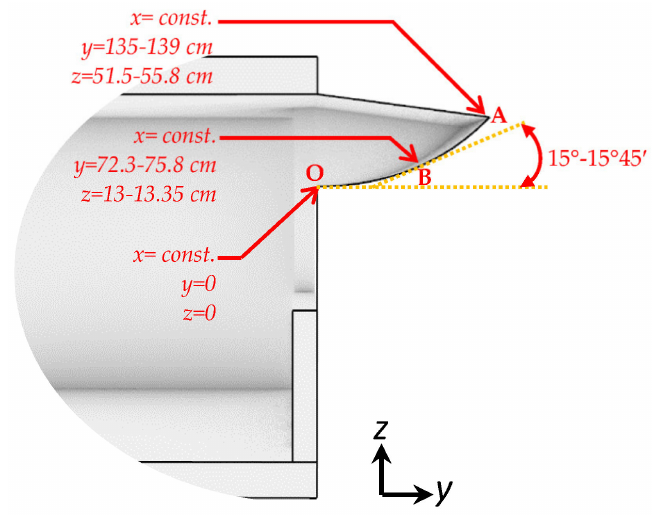
Figure 6. The optimum range curve for the reflector of the